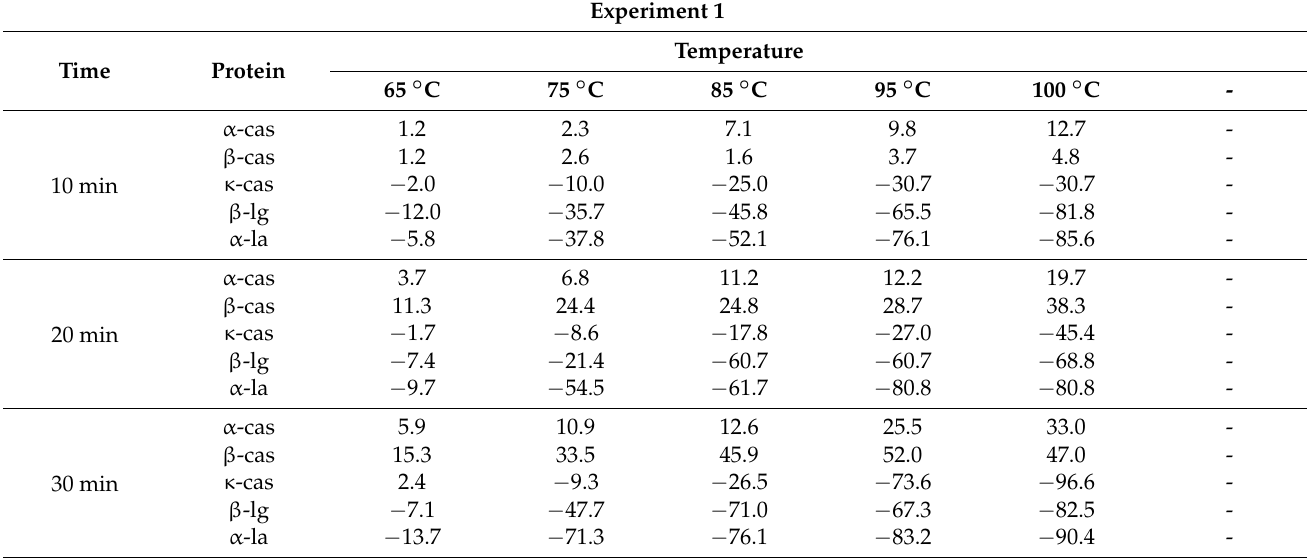
Table 4. Protein denaturation degree